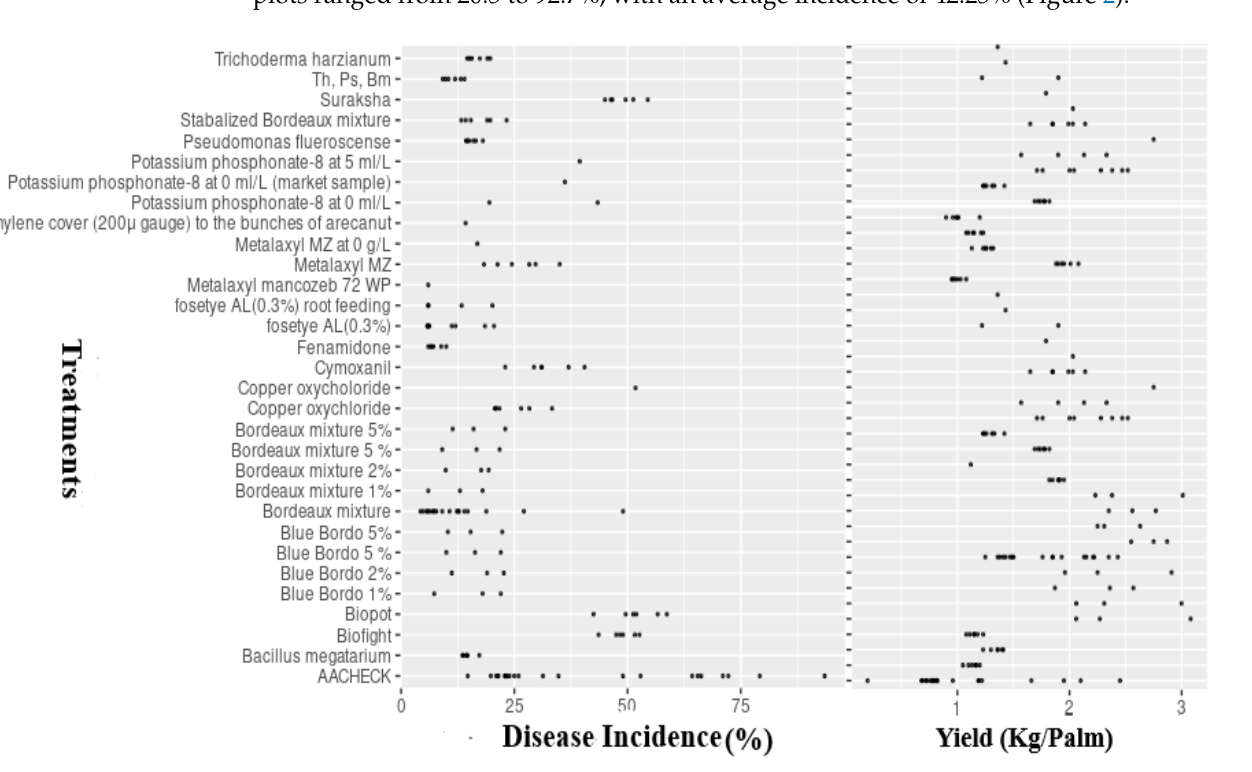
Figure 3. Categorization of trials based on trial mean values for disease pressures and yield levels among the treatments conducted with multi-environment profiles from 2012 to 2019. Th = Tricho- derma harzianum ; Ps = Pseudomonas fluorescence ; Bm = Bacillus megatarium .